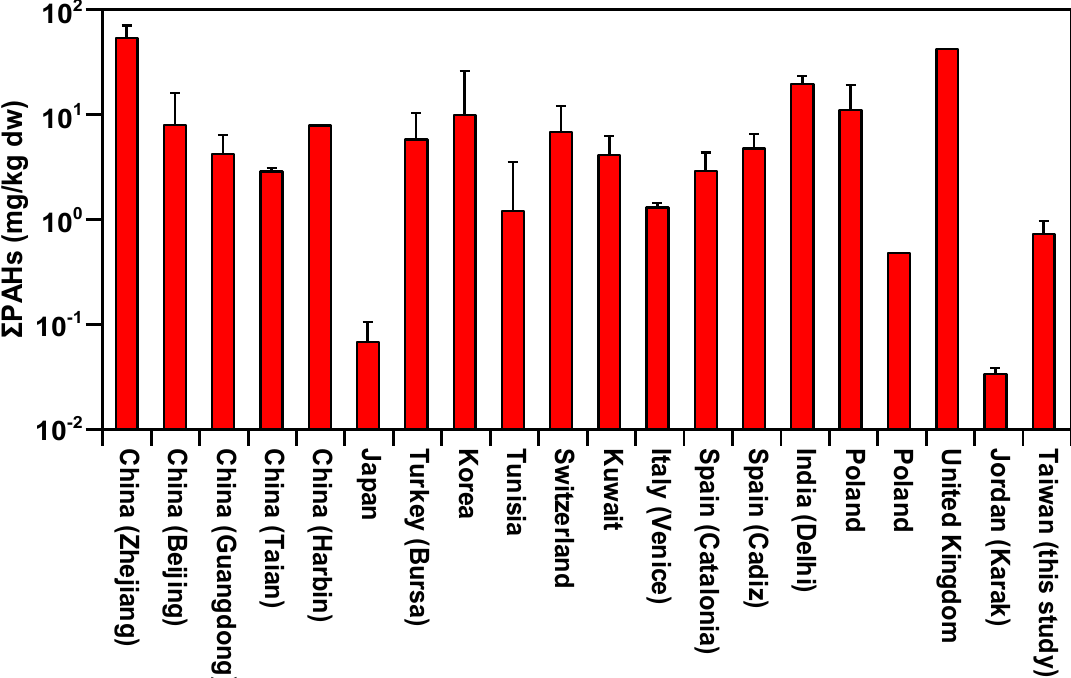
Figure 3. The mean concentrations and standard deviation of Σ PAHs in sludge from other studies around the world (Data list in Table 5).